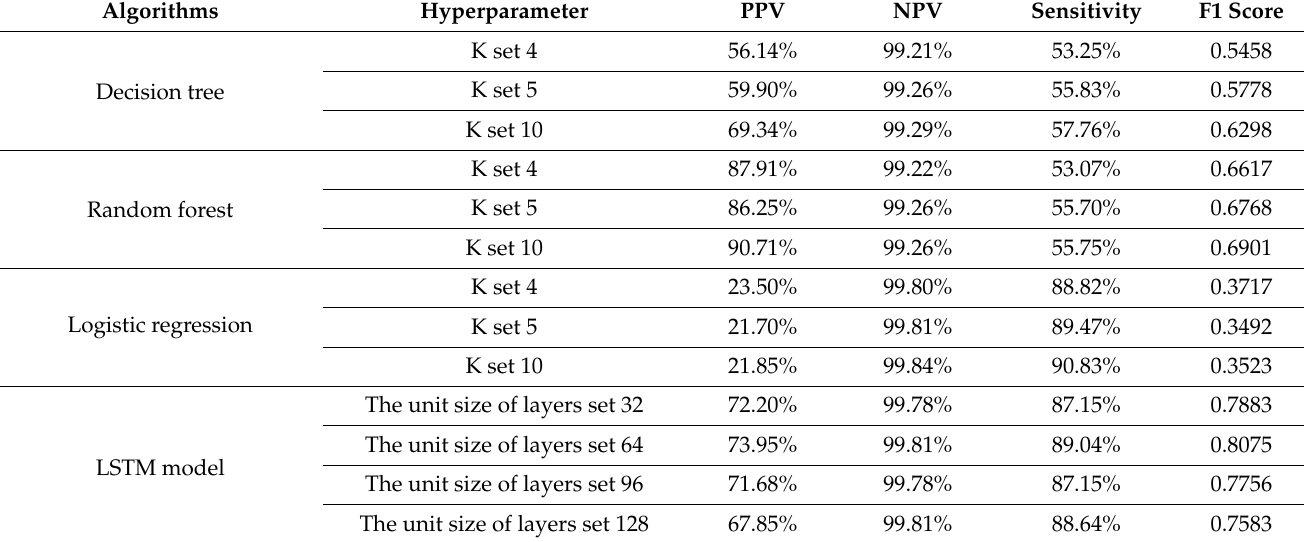
Figure 4. Receiver operating characteristic (ROC) curve of the past patient data range. Table 9. Performance evaluation of the machine learning